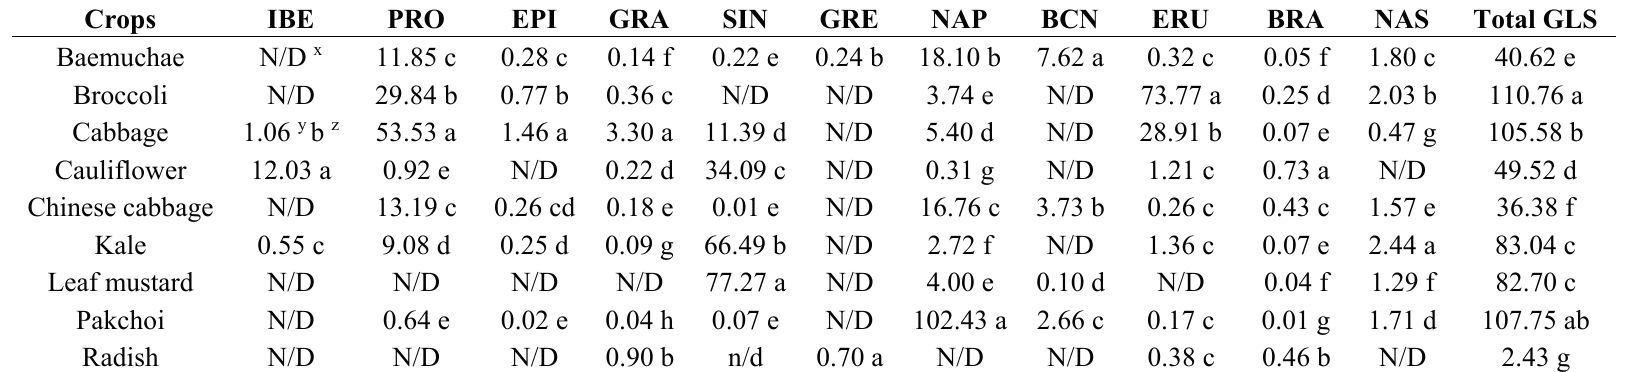
Table 2. Glucosinolate concentration (µmol·g − 1 dry weight) in seeds of nine Brassica vegetables. Crops